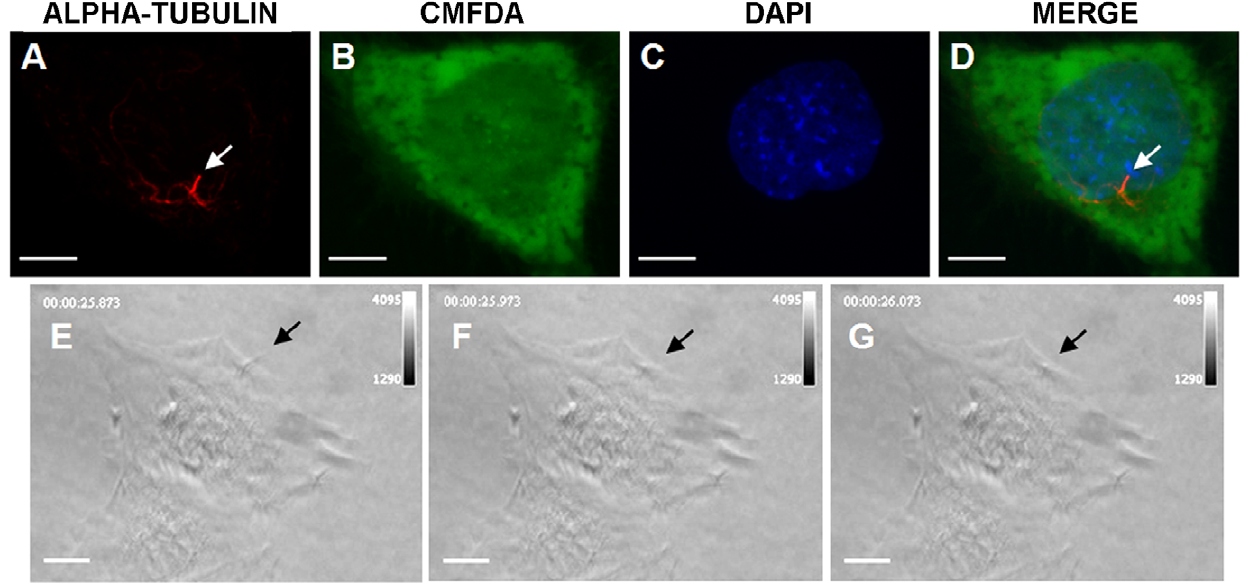
Figure 5. Primary cilium projections from the surface of an MC3T3-E1 osteoblast and its bending during radiation of pulsed ultrasound. The upper panel shows primary cilium stained with an antibody against acetylated a -tubulin (red) (arrowheads, A and D), cell body stained with CMFDA (green) (B and D) and nucleus stained with DAPI (blue) (C and D) in a MC3T3-E1 osteoblast. The lower panel shows the top views of bending movement of a primary cilium (arrowheads) extending from the surface of an MC3T3-E1 osteoblast before (E) and during (F and G)